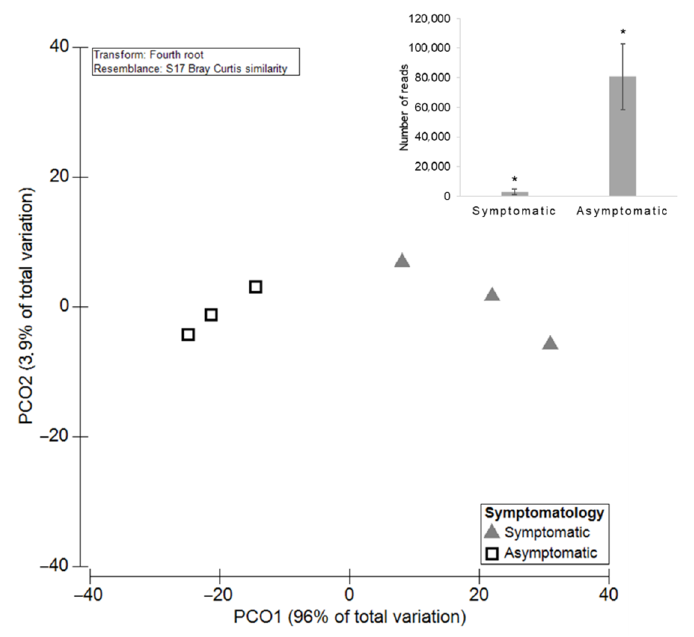
Figure 4. Principal Coordinates Analysis (PCO) based on the diversity of the GTDs-associated fungi among symptomatic and asymptomatic grapevines. The average of the total number of reads for both groups is shown in bar plot and significant differences ( p < 0.05) are indicated by asterisks.